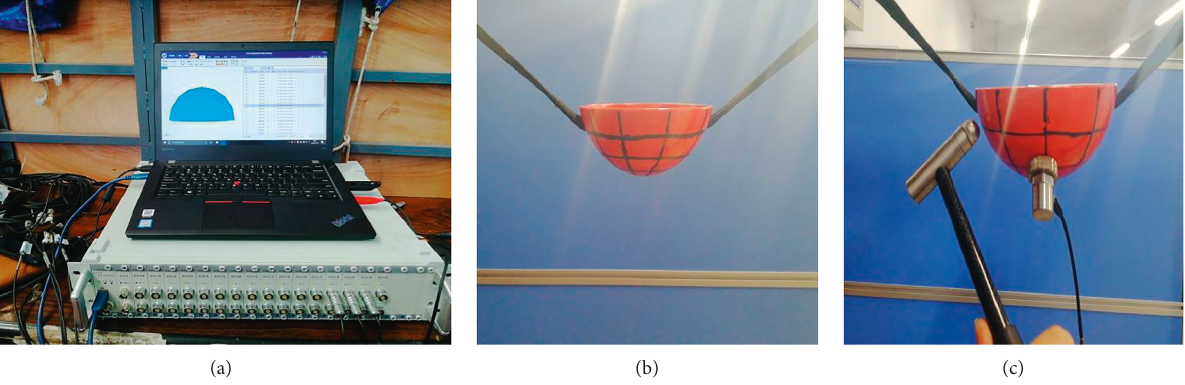
Figure 8: (a) The test system. (b) The test model.